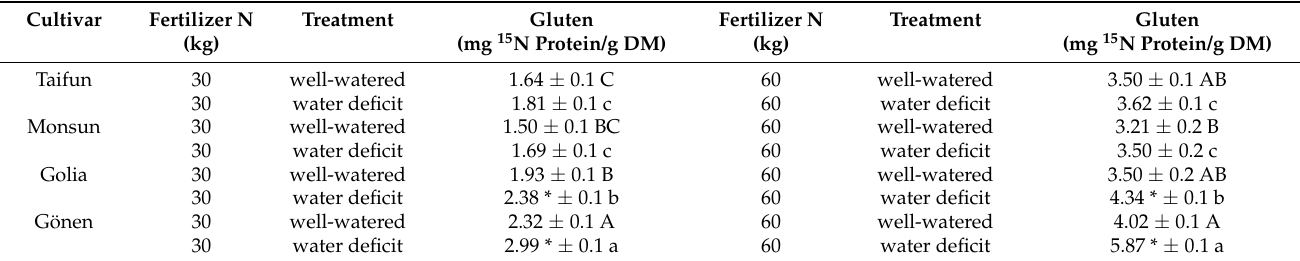
Table 3. 15 N protein in gluten (mean ± SE mg protein/g DM) at maturity of spring wheat cultivars influenced by N fertilization of 30 or 60 kg N applied at beginning of heading (EC 51) of well-watered and water deficit plants, with the beginning at the end of heading (EC 59) for 21 days. (for each N level: well-watered plants: different capitals indicate significant differences between cultivars, Tukey HSD test, p = 0.05, n = 3; water deficit plants: different small letter indicates significant differences between cultivars, Tukey HSD test, p = 0.05, n = 3; * indicate significant difference